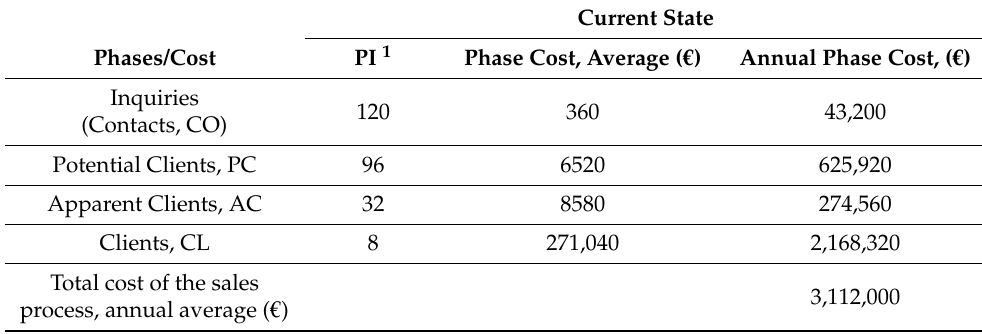
Table 2. Average annual sales process cost—current